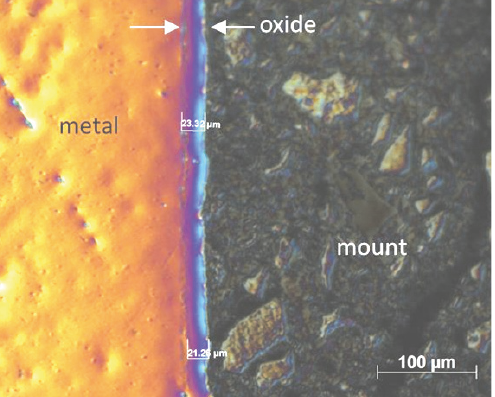
Figure 5: Cross-sectional image of the nonelectropolished and anodised titanium sample to evaluate oxide layer